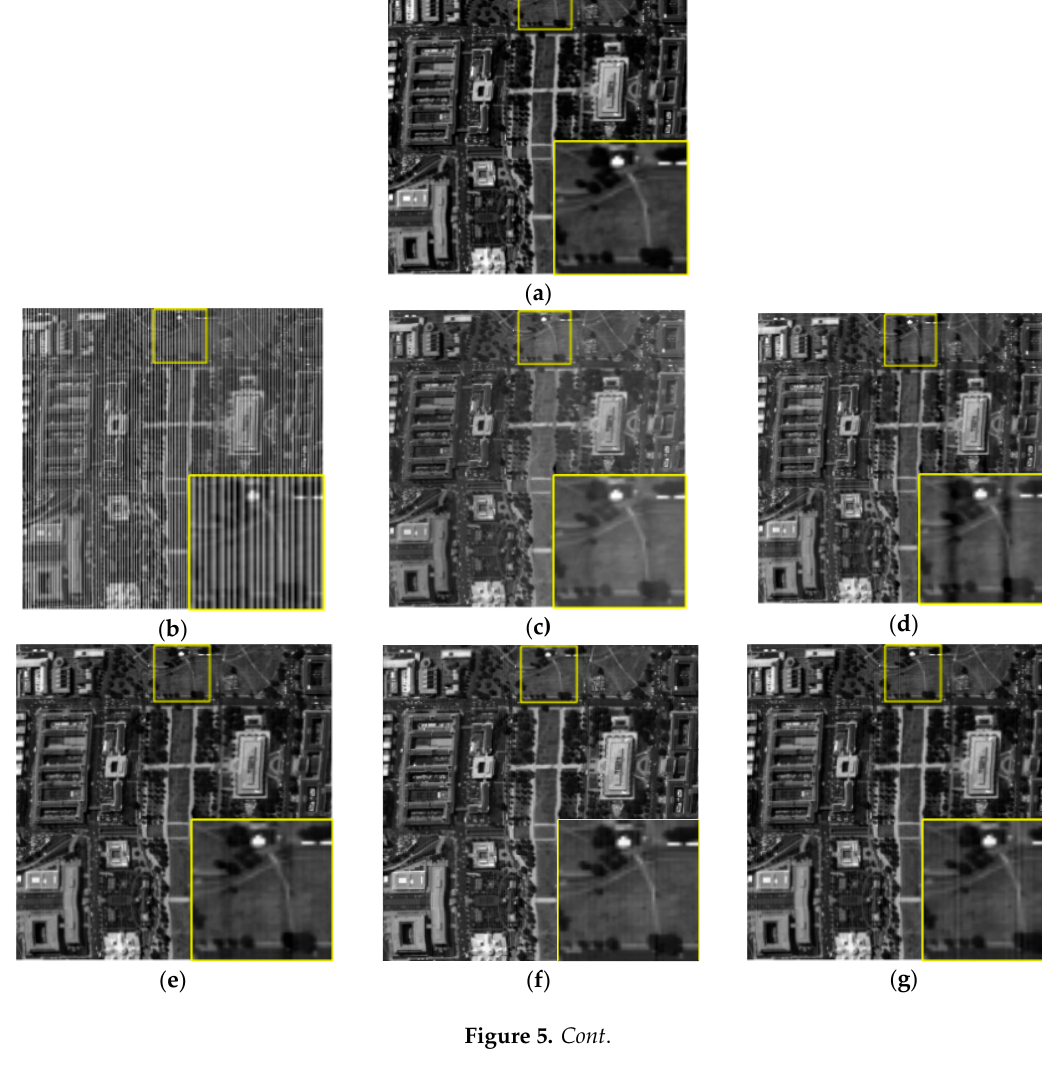
(a) Visual e ff ect comparison: To evaluate the destriping e ff ectiveness of GLTSA, we